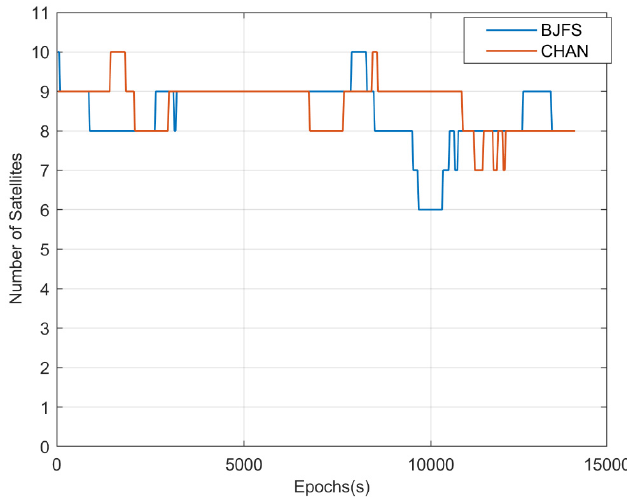
Figure 25. Number of augmented GPS satellites available for BDSBAS MSs.